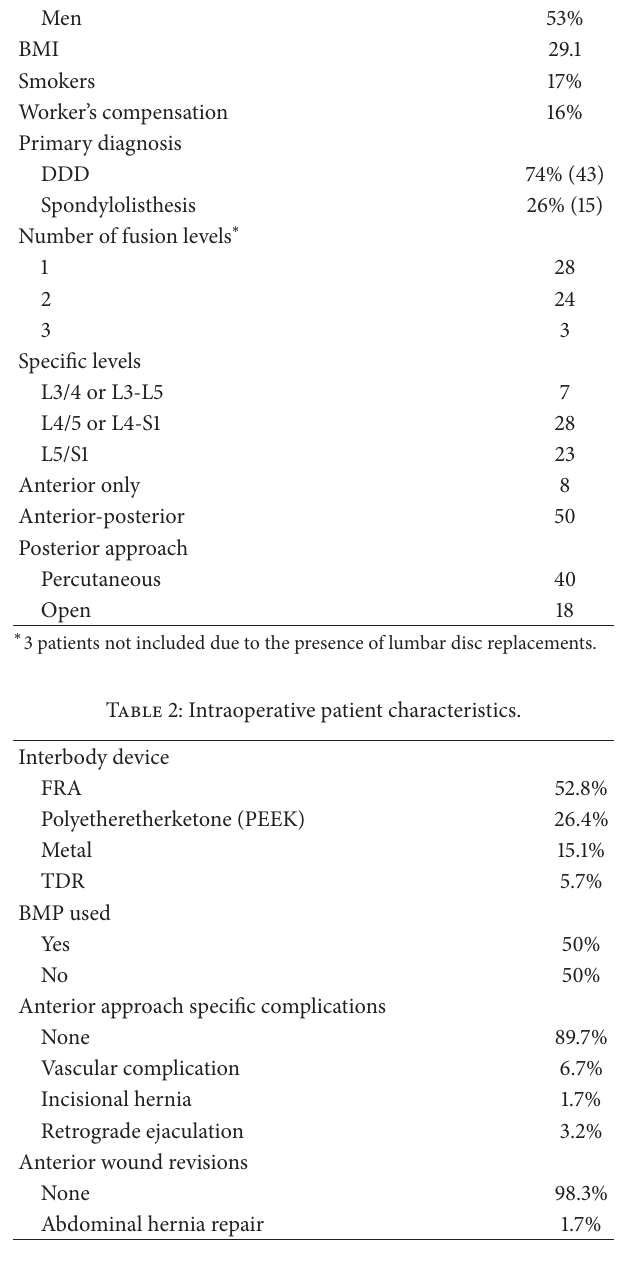
Table 3: Changes in HRQOL